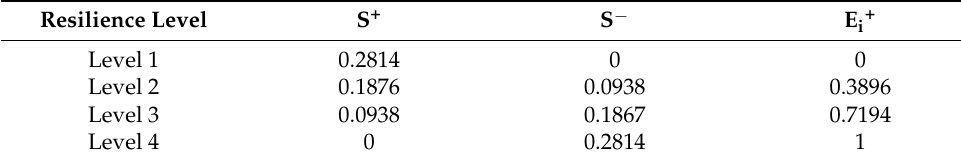
Table 14. Urban stormwater resilience grade